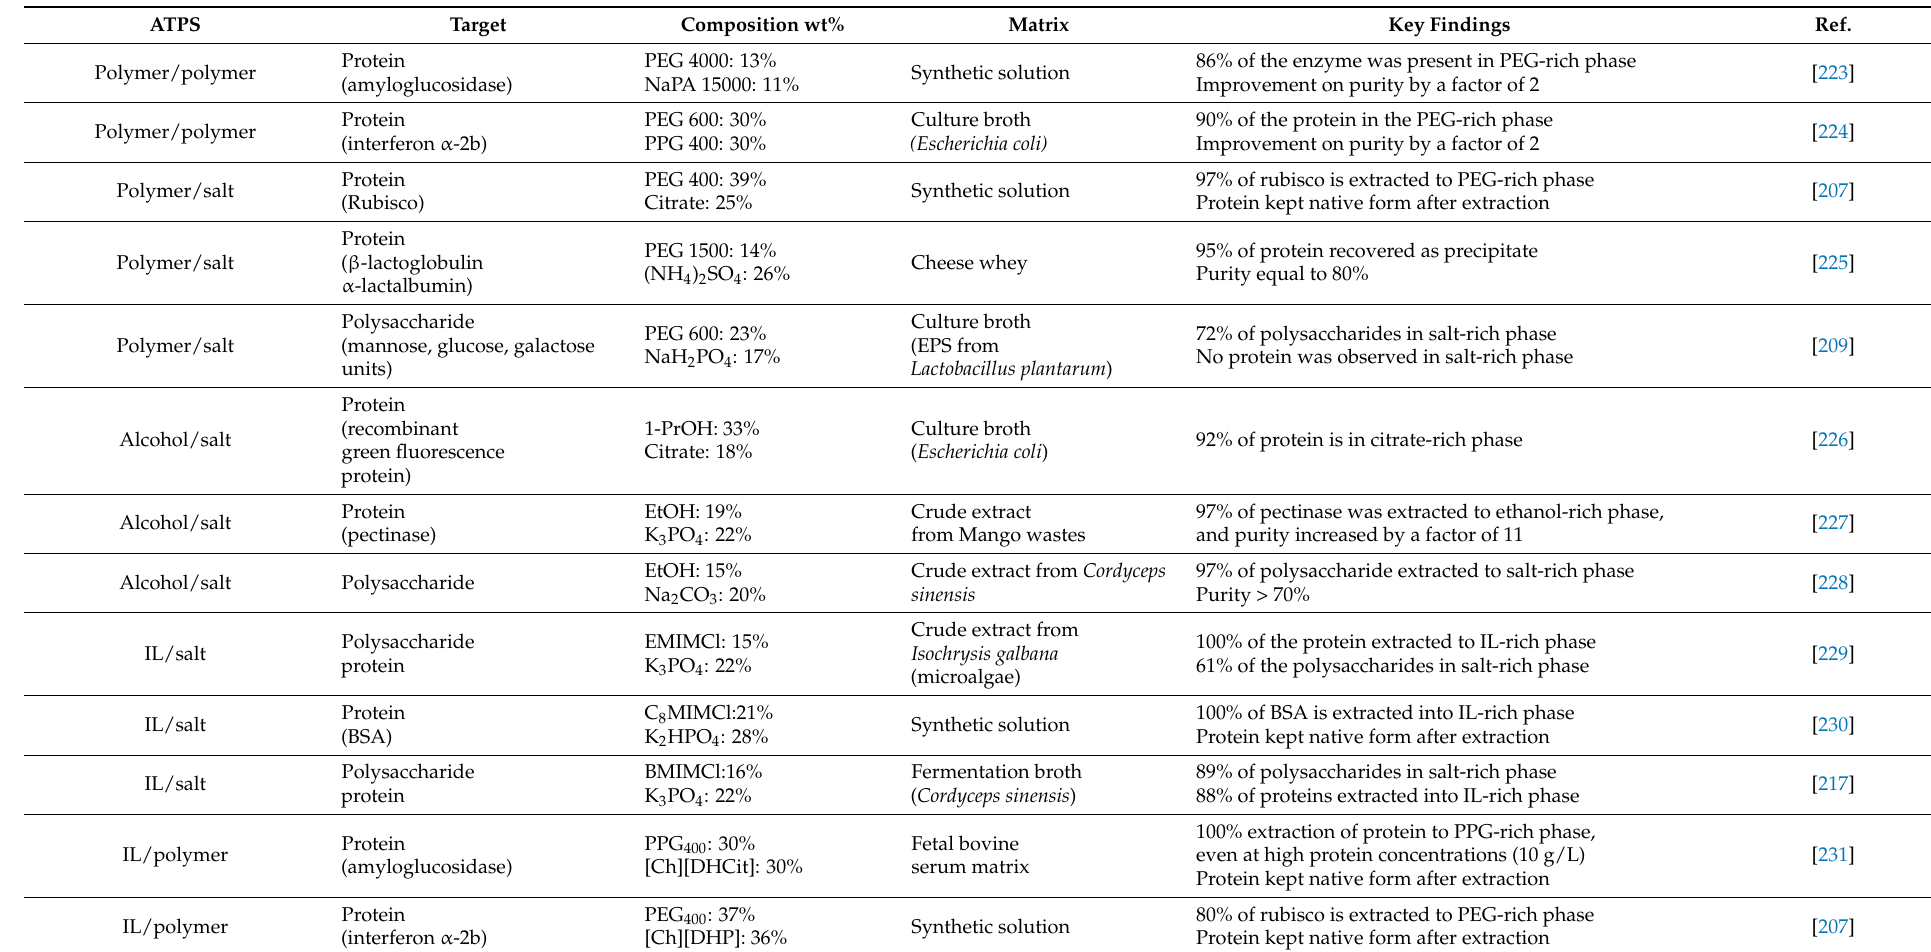
Table 6. Examples of ATPS, reported in the literature, used for the recovery of biopolymers from different